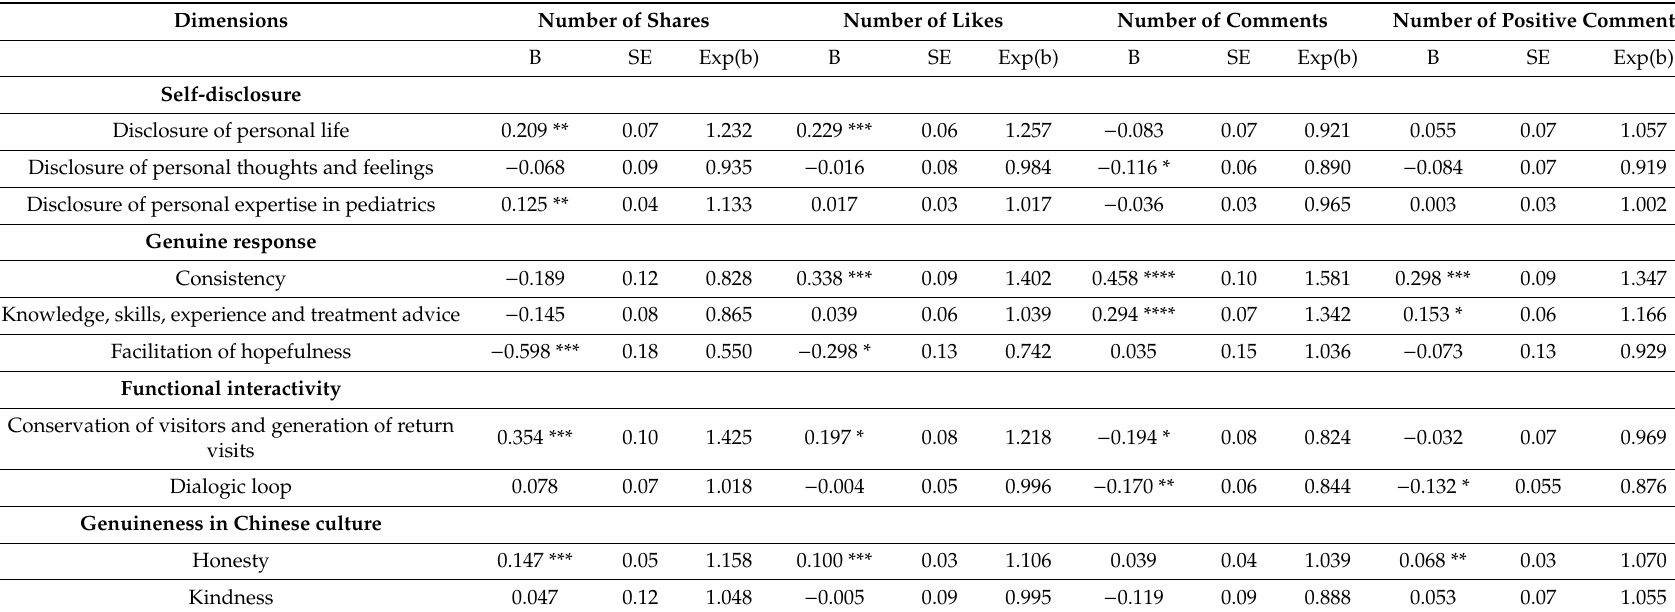
Table 5. Negative Binomial Regression Results on the Sub-dimensions of “Self-disclosure”, “Genuine response”, “Functional interactivity”, “Genuineness in Chinese Culture” and the Number of Shares, Likes, Comments and Positive